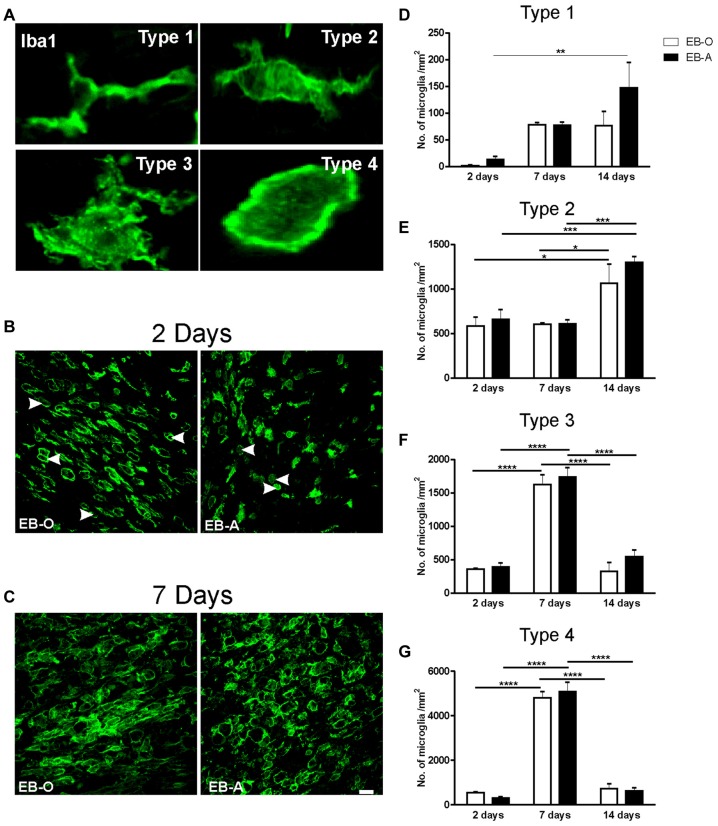
Impact of ADIOL on microglial activation following EB injection into the corpus callosum. Micrographs in (A) show the different stages of microglial activation used in the morphological analysis. Type 1 microglia have a small perikaryon and long processes. Type 2 microglia have larger cell perikaryon and shorter processes than type 1 microglia. Type 3 microglia have a large round cell body and multiple shorter branches, while type 4 has a round cell body with no apparent processes. Micrographs in (B,C) show microglial cells at the center of EB-injected corpus callosum at 2 days and 7 days respectively. Graph bars show cell counts of microglia of type 1 (D), type 2 (E), type 3 (F) and type 4 (G), at 2, 7 and 14 days post-demyelination lesion. There was no significant effect of ADIOL on type 1 microglia at any given time point (D). ADIOL administration led to a significant increase in microglial cell counts at 14 days post-EB-injection when compared to those seen at 2 days (p < 0.01). The number of type 2 microglia was significantly higher at 14 days post-lesion in both oil-treated (p < 0.05) and ADIOL-treated (p < 0.001) rat groups (E). Both type 3 and type 4 microglia peaked at 7 days post-lesion to a significantly higher level when compared to that of 2 days and 14 days rat groups. Such increase was observed in rats given either ADIOL or oil (p < 0.0001; F,G). *p < 0.05, **p < 0.01, ***p < 0.001, **** p < 0.0001. All data are presented as mean ± SEM. Scale bar = 50 μm.